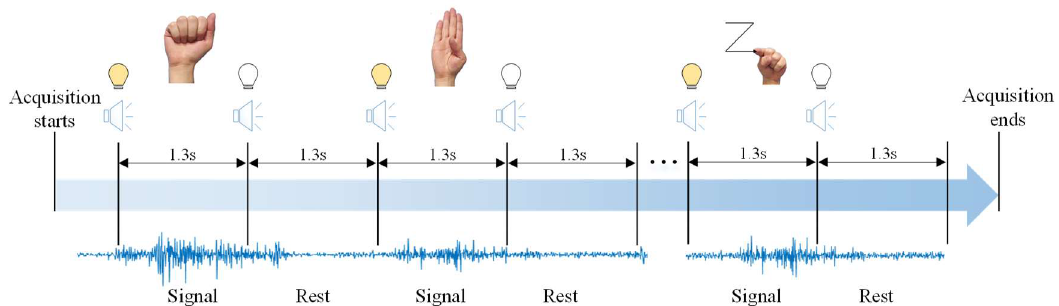
Figure 3. Sequence for sEMG signals acquisition. When the acquisition started, a light and a buzzer indicated that the subject should perform the gesture. After the 1.3 s, the light indicator turned off and the buzzer indicated to the subject to rest. After 1.3 s, both indicators turned on, repeating this process until the acquisition was completed.